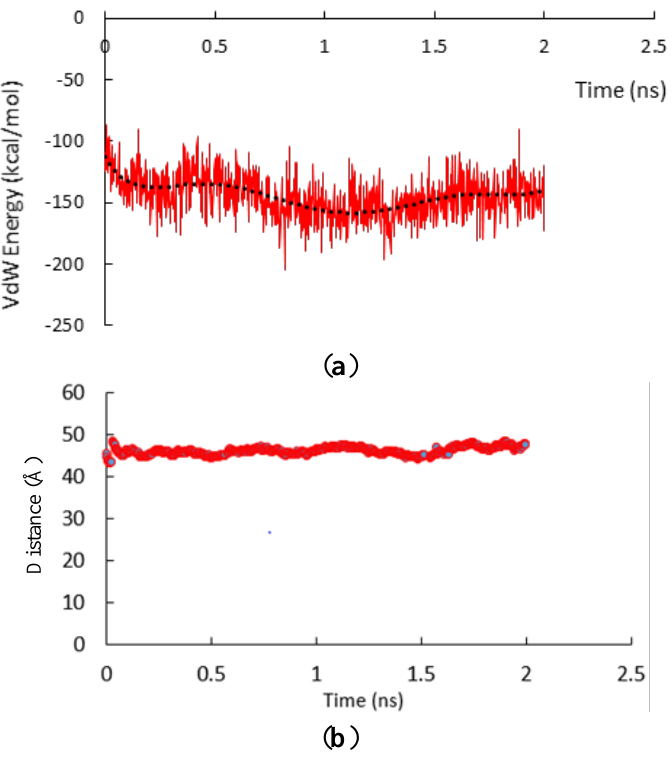
Figure 3. ( a ) Van der Waals energy interaction between the two subunits. ( b ) Distance between the central of mass of the two α-subunit vs time in all atom SMD